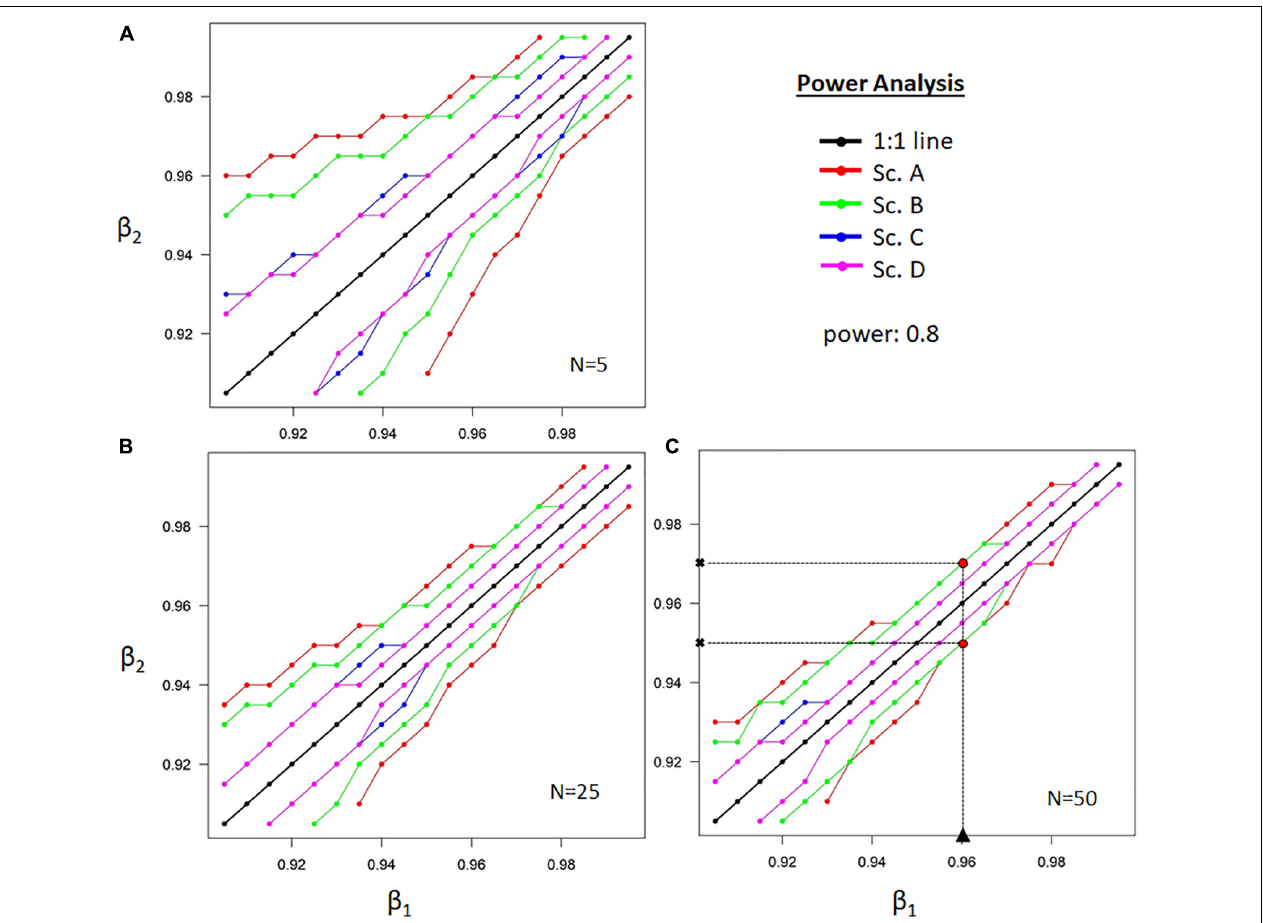
FIGURE 5 | The power analysis shows the combinations of two allocation parameters that define the exponential vertical decay of the distribution of absorbing root surface with soil depth ( β ) of two independent datasets for a given sample size N , required to detect significant differences. Regions bounded by lines are non-significant (at the 95% level). The different colors correspond to four scenarios, as described in the main text and Figure 2 . Panel (A–C) , respectively show power analysis for sample sizes of 5, 25, and 50 samples. The level of confidence of finding significant differences, i.e., the power, is set at 0.8. An example is provided in (C) for a study case with β 1 = 0.96, N = 50 and no restrictions (Sc A.). Significant differences can be expected with a power of 0.8 when the compared species has β -values outside the delineated range of both obtained β 2